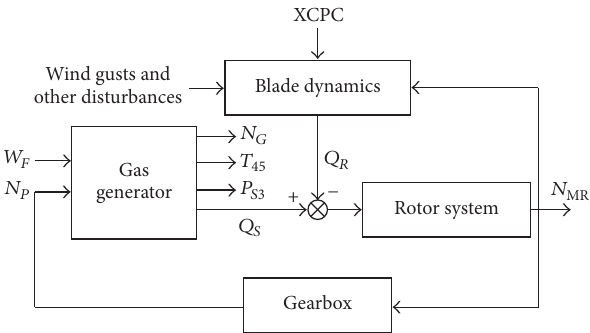
Figure 1: Block diagram of the open-loop gas generator/rotor sys-